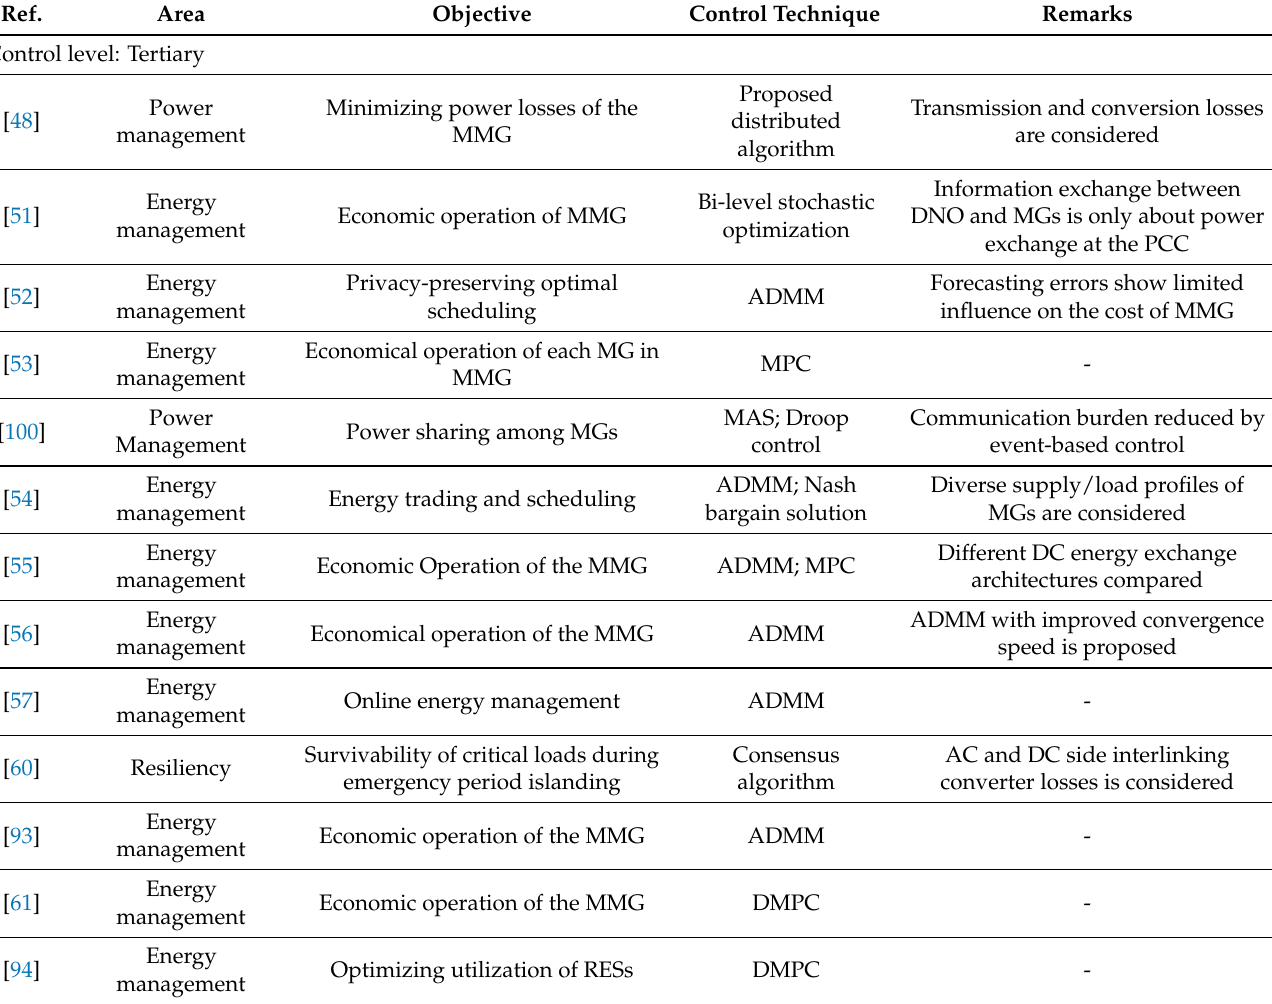
Table A3. Summary of the recently published articles on the distributed control of MMGs.